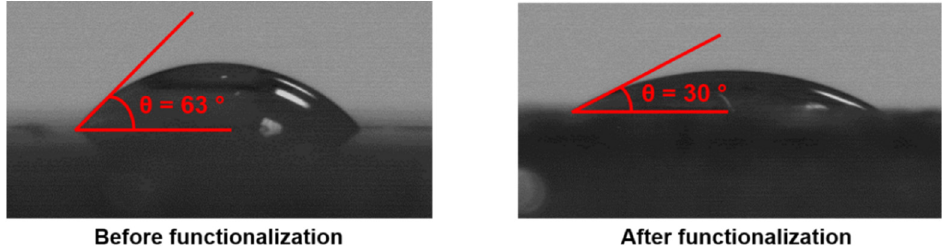
Figure 8. Water contact angle measurements realized on polymers prepared from vanillin methacry- late before and after functionalization with AEP.